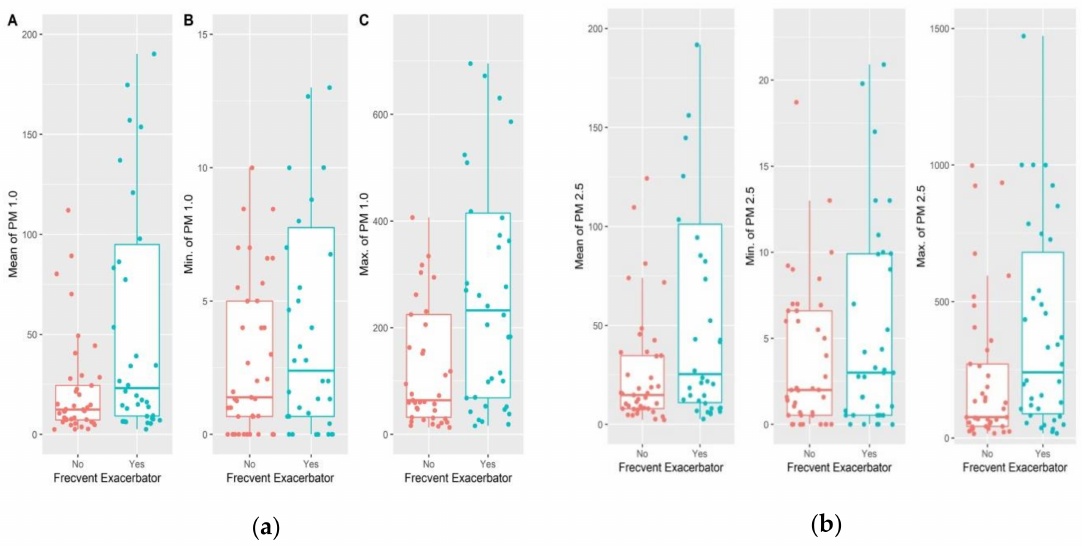
Figure 3. Difference in PM values at participants’ houses according to frequency of exacerbations: ( a ) Average overall (A), minimum (B) and maximum (C) PM 1.0 values; ( b ) Average overall, minimum and maximum PM 2.5 values.